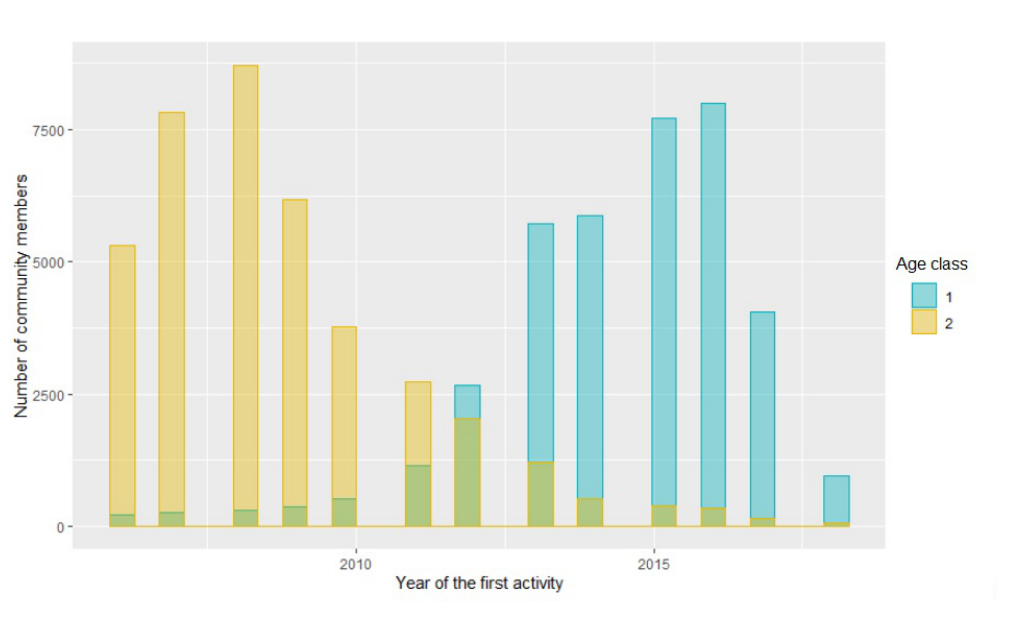
Figure 10. Histograms of the top variable selected by RF classifiers. It displays the values for two youngest cohorts (1 = Gen Z, 2 = Gen